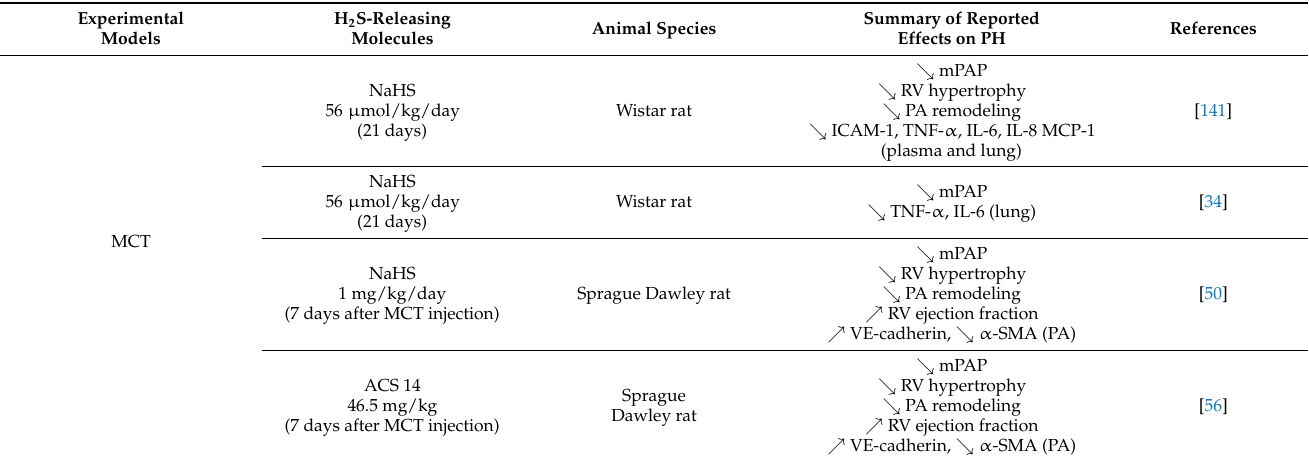
Table 1. Summary of reported effects of the use of H 2 S-releasing molecules on various experimental PH models. α -SMA: α - smooth muscle cell actin; ATF6: activating transcription factor 6; BAL: bronchial alveolar lavage; CO: carbon monoxide; ET-1: endothelin-1; ER: endoplasmic reticulum; GYY4137: morpholin-4-ium 4-methoxyphenyl (morpholino) phosphinodithioate; Grp78: binding immunoglobulin protein; HO-1: heme oxygenase-1; ICAM-1: intercellular adhesion molecule-1; mPAP: mean pulmonary artery pressure; NaHS,: sodium hydrosulfide; PA: pulmonary artery; PAECs: pulmonary artery endothelial cells; PASMCs: pulmonary artery smooth muscle cells; RV: right ventricle; TNF- α : tumor necrosis factor- α ; IL-6/8: interleukin 6/8; VE-cadherin: vascular